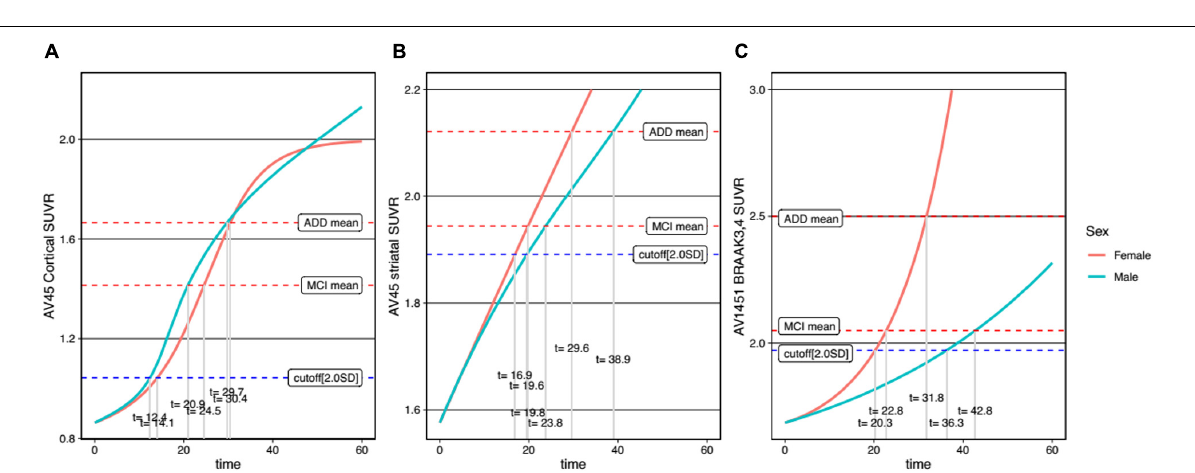
FIGURE 5 | Temporal trajectories of AD biomarkers stratified by sex in cortical amyloid (A) , striatal amyloid (B) , and pathological tau (C) . AV45, 18 F-florbetapir; SUVR, standardized uptake value ratio; AV1451, 18 F-flortaucipir; MCI, mild cognitive impairment; ADD, Alzheimer’s disease dementia.